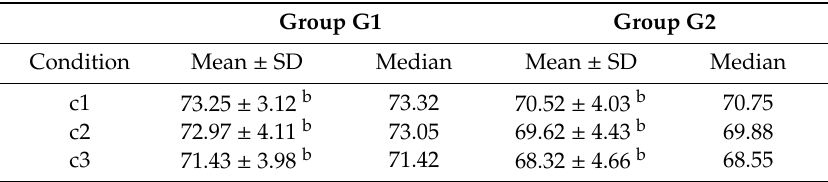
Table 4. Comparison of lingual BIC% values between the two groups under the three conditions at time 2 (3 months after implant placement).